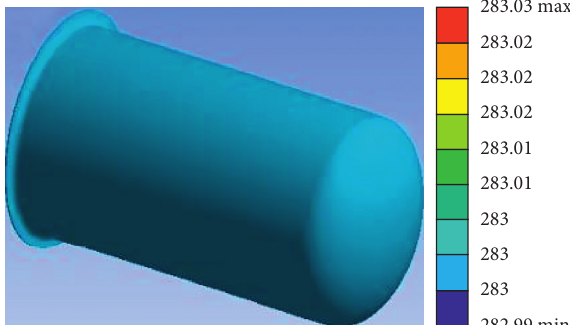
Figure 20: Temperature cloud diagram of the flame tube body.